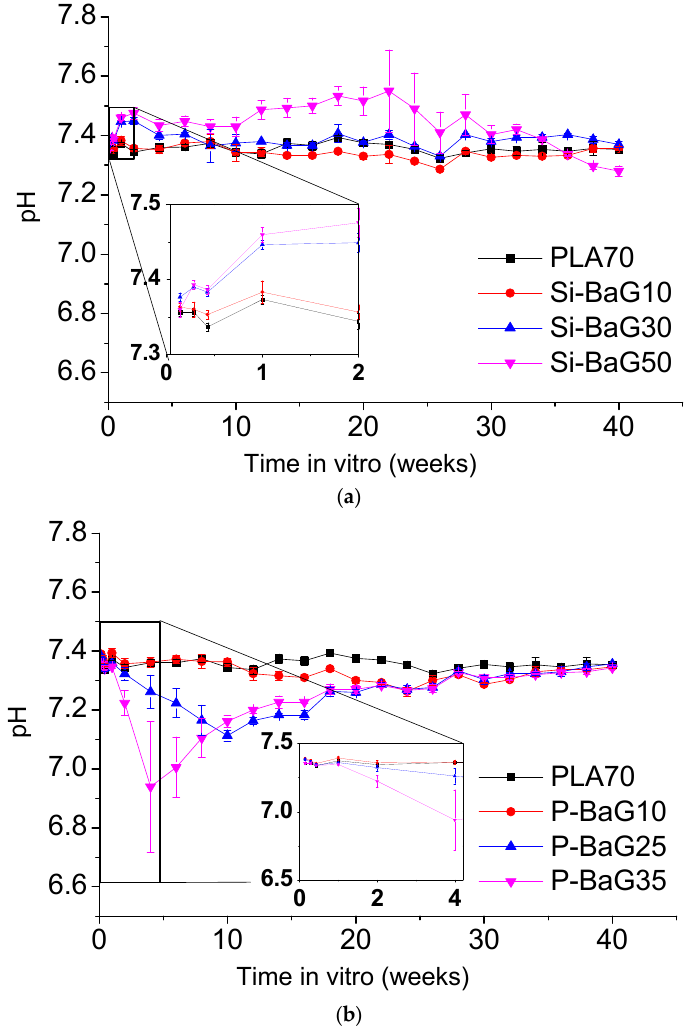
Figure 3. pH of the buffer solution with PLA70 and its composites with ( a ) Si-BaG and ( b ) P-BaG during 40 weeks in